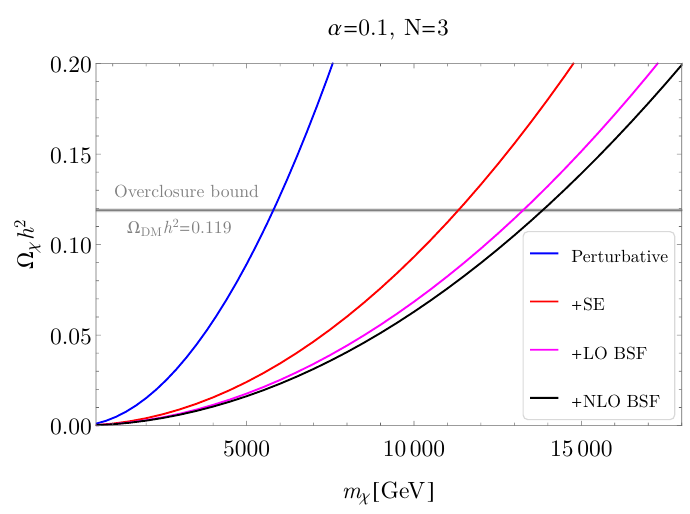
Figure 9 . Under the assumption of a strong coupling (cid:11) = 0 : 1 and one quark in the plasma, we show the predicted relic abundance when considering a tree-level cross section only (blue), including the Sommerfeld e(cid:11)ect (red), considering BSF via LO on-shell emission (pink), as well as BSF at NLO